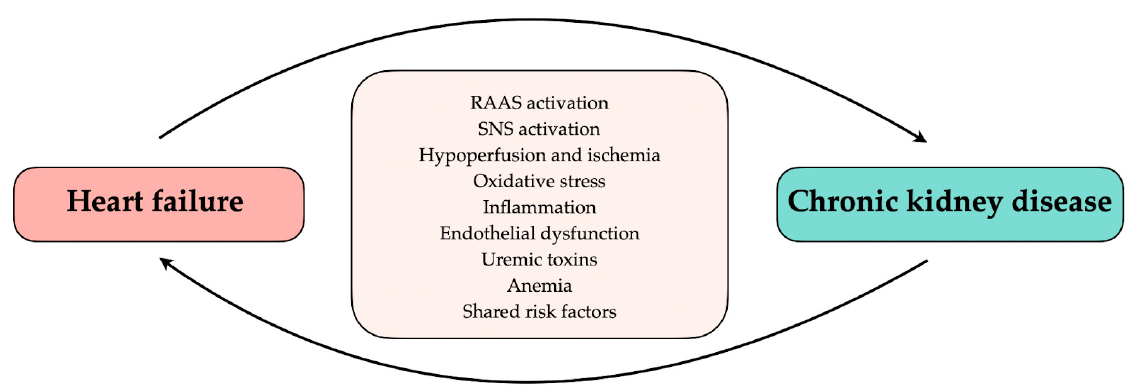
Figure 1. Relationship between heart failure and chronic kidney disease. RAAS, renin–angiotensin– aldosterone system; SNS, sympathetic nervous system.